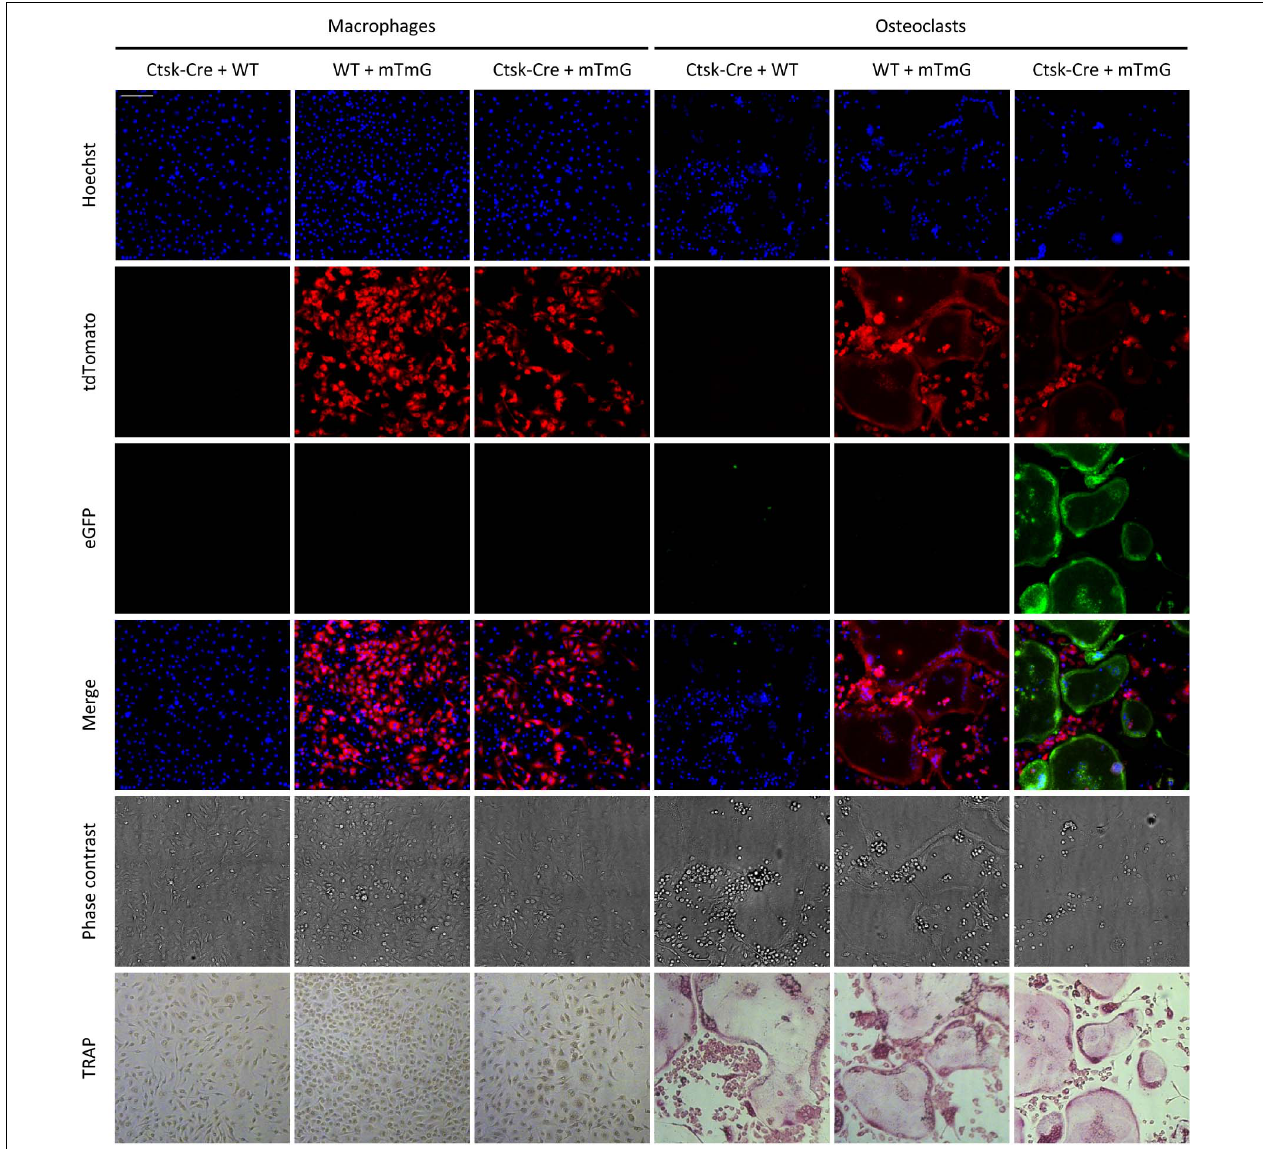
FIGURE 6 | Fluorescence and brightfield images of the FRAMCO1.2 (intercellular fusion) assay. Representative images of macrophage and osteoclast co-cultures on Day 5 after RANKL addition. Nuclei were labeled with Hoechst. The first three rows show images from the blue, red, and green fluorescence channels, supposedly corresponding to signals from the indicated fluorophores. The cells were fixed and stained for TRAP after fluorescence imaging. Images in each column show the same field of view. The scale bar corresponds to 100 µ m and applies to every image. Images are representative of 8–10 independent